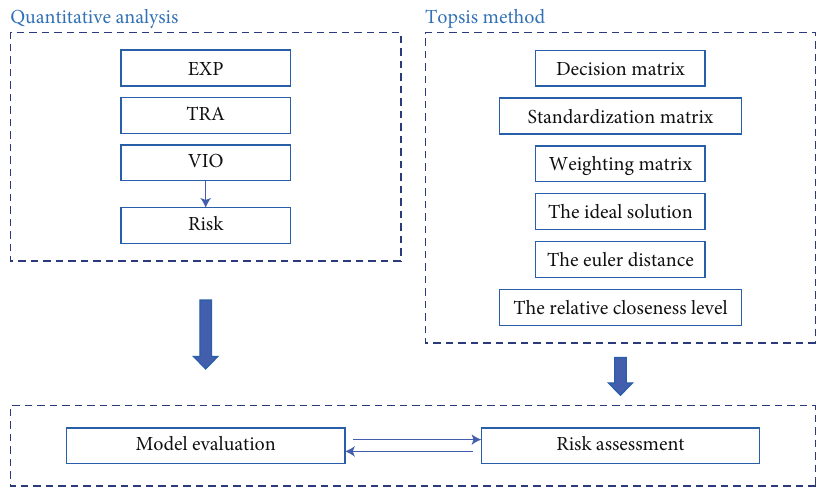
Figure 5: Schematic diagram of model processing and risk